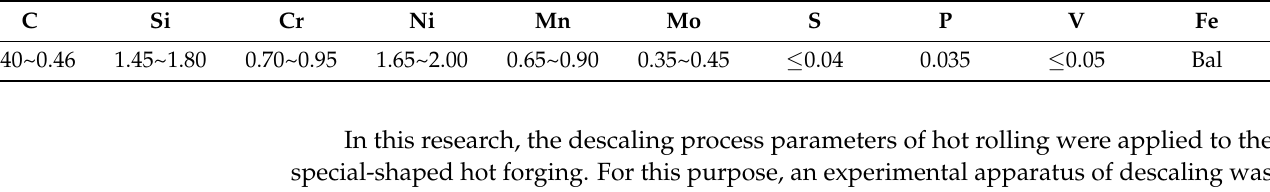
Figure 6. A schematic diagram of the local physical model and meshing of the special ‐ shaped hot forging: ( a ) physical model; ( b ) unstructured grid meshing.